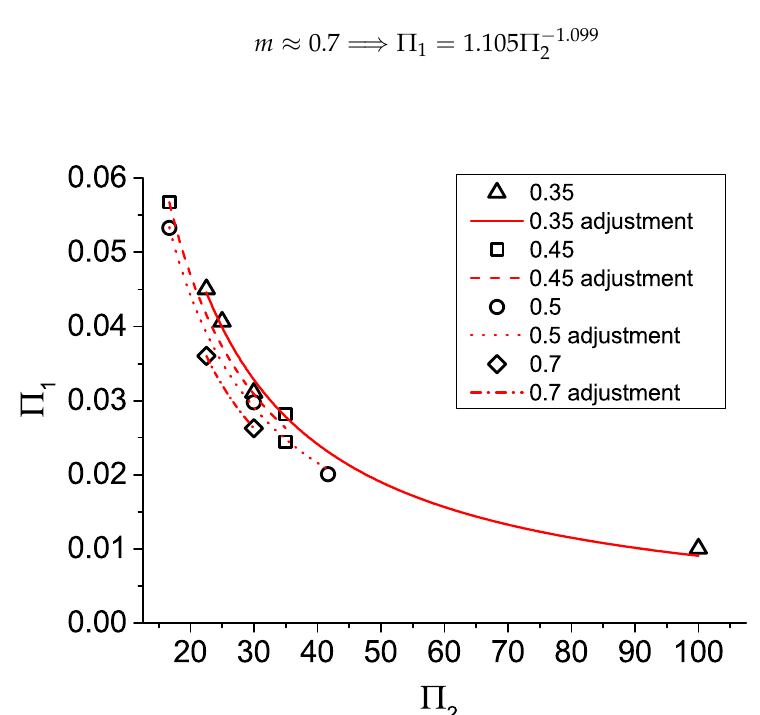
Figure 3. Π 1 vs. Π 2 . Fitting power law functions are extracted for the four